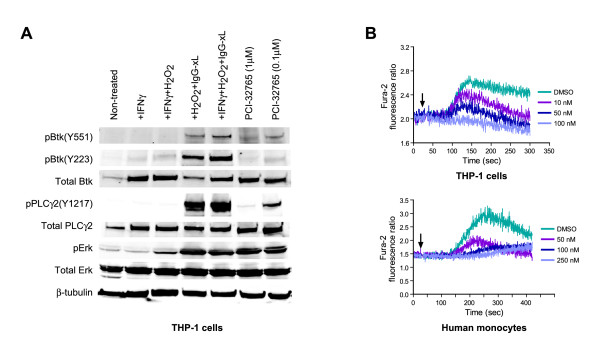
PCI-32765 inhibits FcγR signaling in monocytes. (a) Inhibition of Btk signaling in THP-1 cells. THP-1 cells were stimulated with IFN-γ and pretreated with PCI-32765 (1 μM or 0.1 μM) or vehicle and stimulated by cross-linking with human IgG and goat anti-human IgG in the presence of H2O2 and IFNγ. Cell lysates were subjected to western blot analysis and probed with the indicated antibodies. (b) Inhibition of calcium mobilization in THP-1 cells (upper panel) or human monocytes (lower panel) stimulated with cross-linked IgG as described in Materials and Methods.